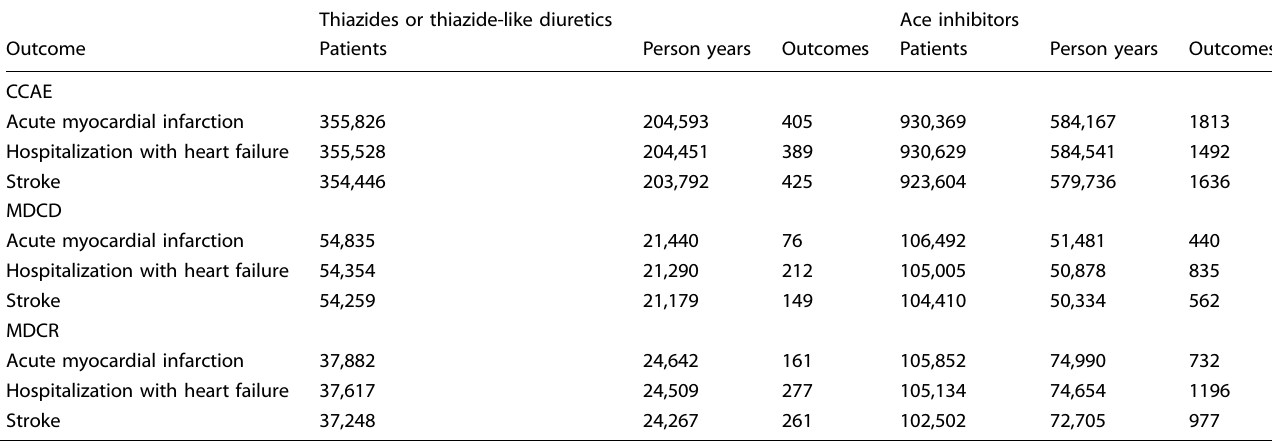
Table 1. Sample sizes. Number of patients, person years and events for the three ef fi cacy outcomes of the study across the three databases after excluding patients with prior outcomes.